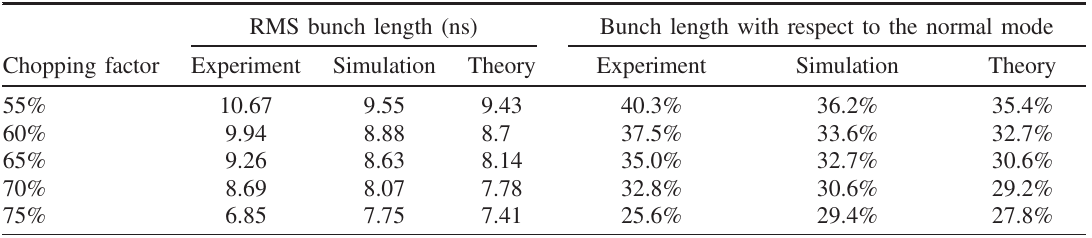
TABLE II. Comparison between the extraction bunch lengths among the different chopping